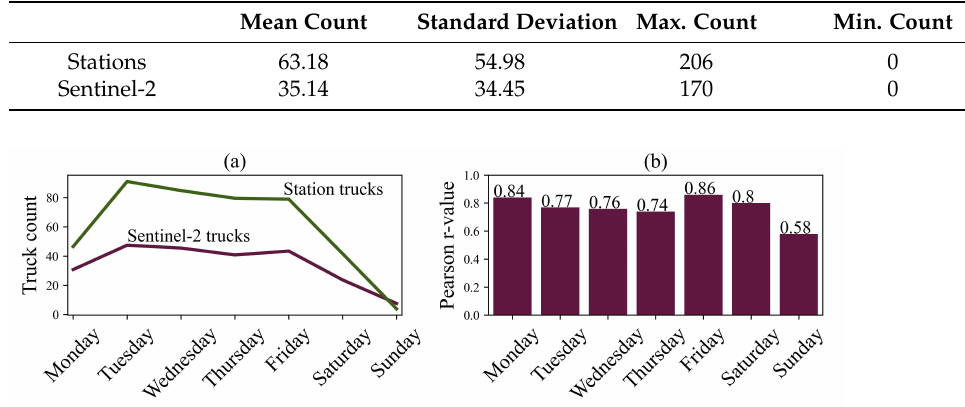
Figure 12. ( a ) Mean station and Sentinel-2 truck counts. ( b ) r values by